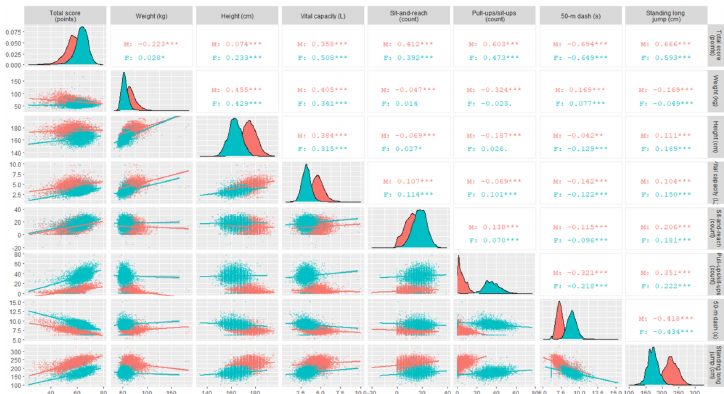
Figure 2. Scatterplot matrix of the total score and numerical measurements of seven single tests from 11,346 records for the 3202 subjects (red for males (M) and blue for females (F)), with their units in parenthesis and their density curves on the diagonal. The lower triangle shows the scatter plots of one variable on the y axis against another variable on the x axis, with linear regression line for each sex. The upper triangle shows the Pearson correlation coe ffi cients between these variables, with three, two, and one stars, and one dot indicating statistical significance at the α = 0.001, 0.01, 0.05, and 0.1 level, respectively. Correlation coe ffi cients with an absolute value > 0.3 meet the criterion for variable selection in this study (see Materials and Methods